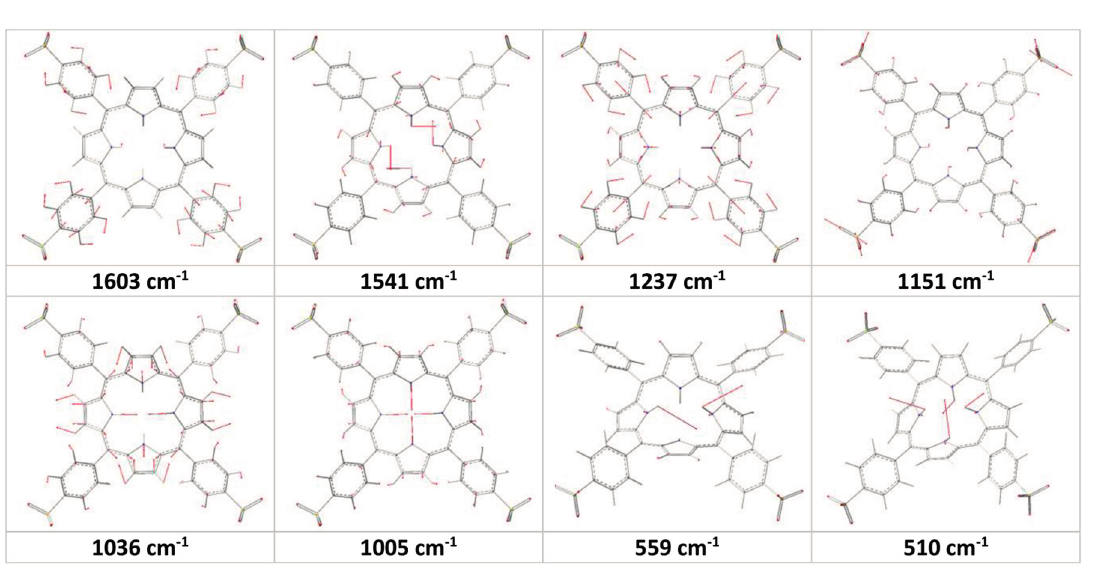
Figure 3. Calculated molecular motions for some vibrational bands of the H 2